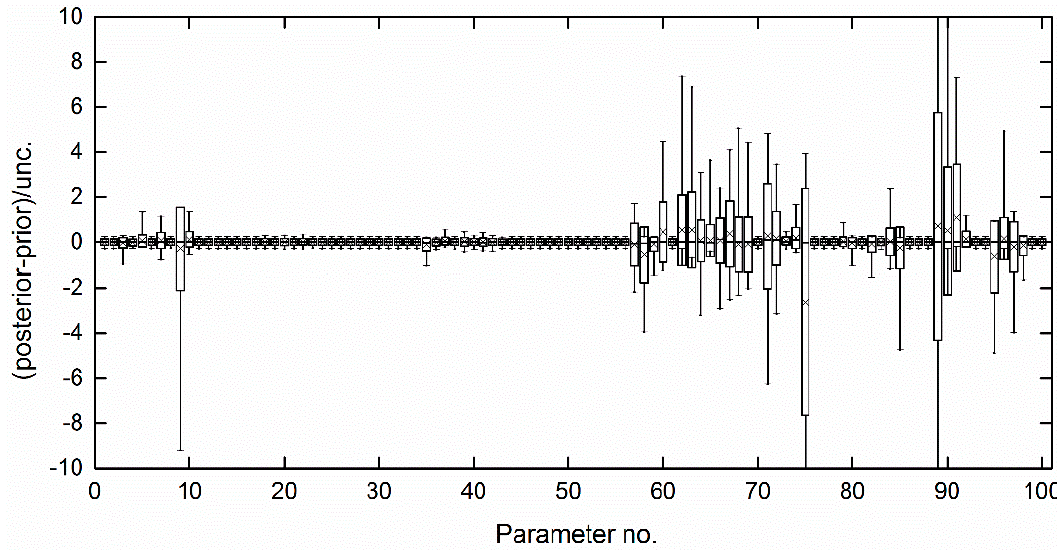
Figure 5. Parameter value changes relative to prior for all assimilation experiments (29 in total), with a cross symbol indicating the mean of changes, box for standard deviation, and whisker for max and min values, parameter numbers correspond to the numbers listed in Table S2.